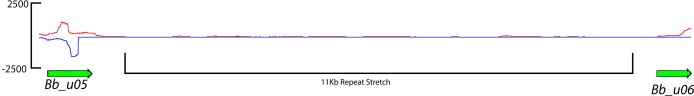
Example of an extensive, untranscribed sequence of B. burgdorferi.Read coverage histograms of the 11kb direct-repeat sequence within the naturally-occurring plasmid lp21. Red lines indicate relative transcript abundance from the + strand (left to right) and blue indicate relative transcript abundance from the–strand (right to left), and reside above (+) and below (-) the central axis. Genes are noted below coverage plots and directionality is indicated by arrows at the ends of genes. Relative orientation of genes on the X axis is consistent with RefSeq annotations. Coverage per base is given on the Y axis to the right of the plot.